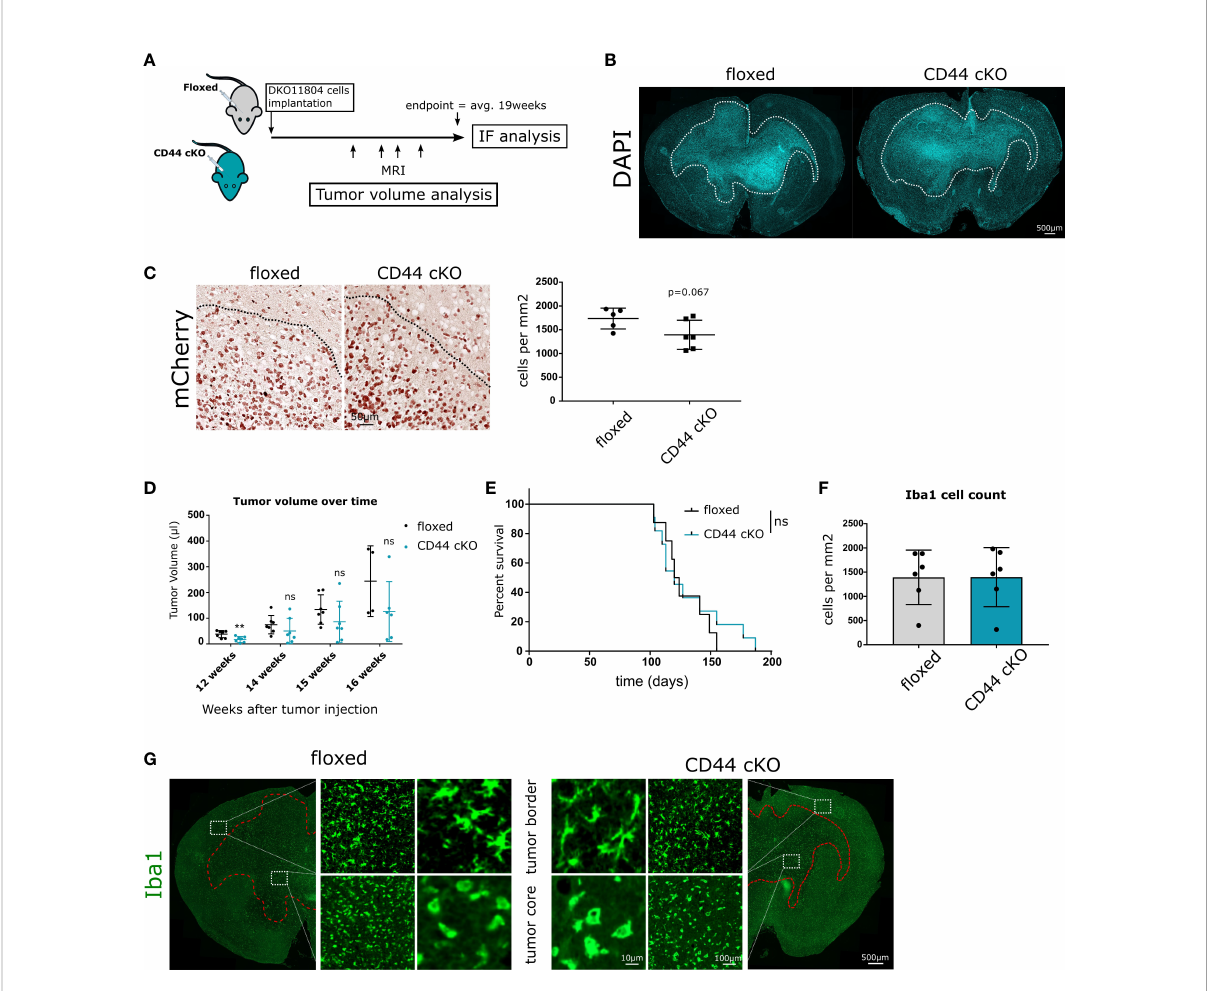
FIGURE 3 Effects of Myeloid-speci fi c CD44 knock-out in vivo . (A) 1 × 10 6 DKO11804 mCherry labelled cells were implanted in 5-8 weeks old fl oxed or CD44 cKO mice. MRI imaging was performed at weeks 12, 14, 15 and 16 after tumor cells implantation. Animals were sacri fi ced at endpoint, on average 19 weeks after injection and IF/IHC Analysis were performed. (B) Representative images of brains from fl oxed and CD44 cKO tumor- bearing mice stained with DAPI. Dashed line delimits tumor and shows invasive growth pattern. (C) Left-Representative images of tumors stained with mCherry. Dashed lines delimit the tumor core. Right-Quanti fi cation of the number of mCherry-positive tumor cells migrating beyond the tumor border. The tumor border was manually drawn and the number of cancer mCherry-positive cells spreading in a radius of 300 microns was counted. Data are presented as mean ± SD. Student ’ s t-Test, p=0.067. (D) Tumor growth was monitored with MRI. Graphs represent tumor volume ( m l) for individual mice calculate from T2- weighted images. ” by “ Graphs represent tumor volume ( m l) for individual mice calculated from T2-weighted images. Data are presented as mean ± SD. Student ’ s t-Test, ** p<0.01; n.s. = not-signi fi cant. (E) Kaplan- Meier plot of survival for fl oxed (n=11) and cKO (n=8) mice transplanted with 1 × 10 6 DKO11804. Time = days. Log-rank (Mantel-Cox) test, n.s. = not-signi fi cant. (F – G) Myeloid cells recruitment and morphology at endpoint. (F) Bar charts depict the number of Iba1 positive cells per mm 2 in the tumor core. Student ’ s t-Test. (G) Representative images of Iba1- positive cells. At the tumor border, labelled cells present with rami fi